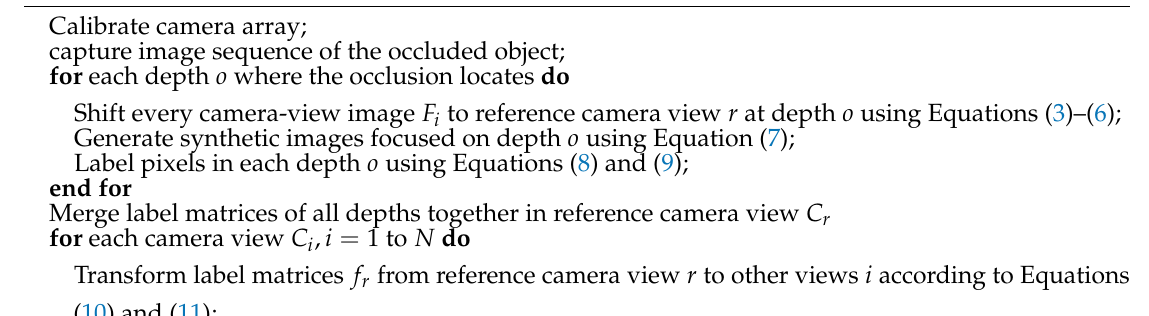
Algorithm 1 3D reconstruction of occluded object with camera array using synthetic aperture